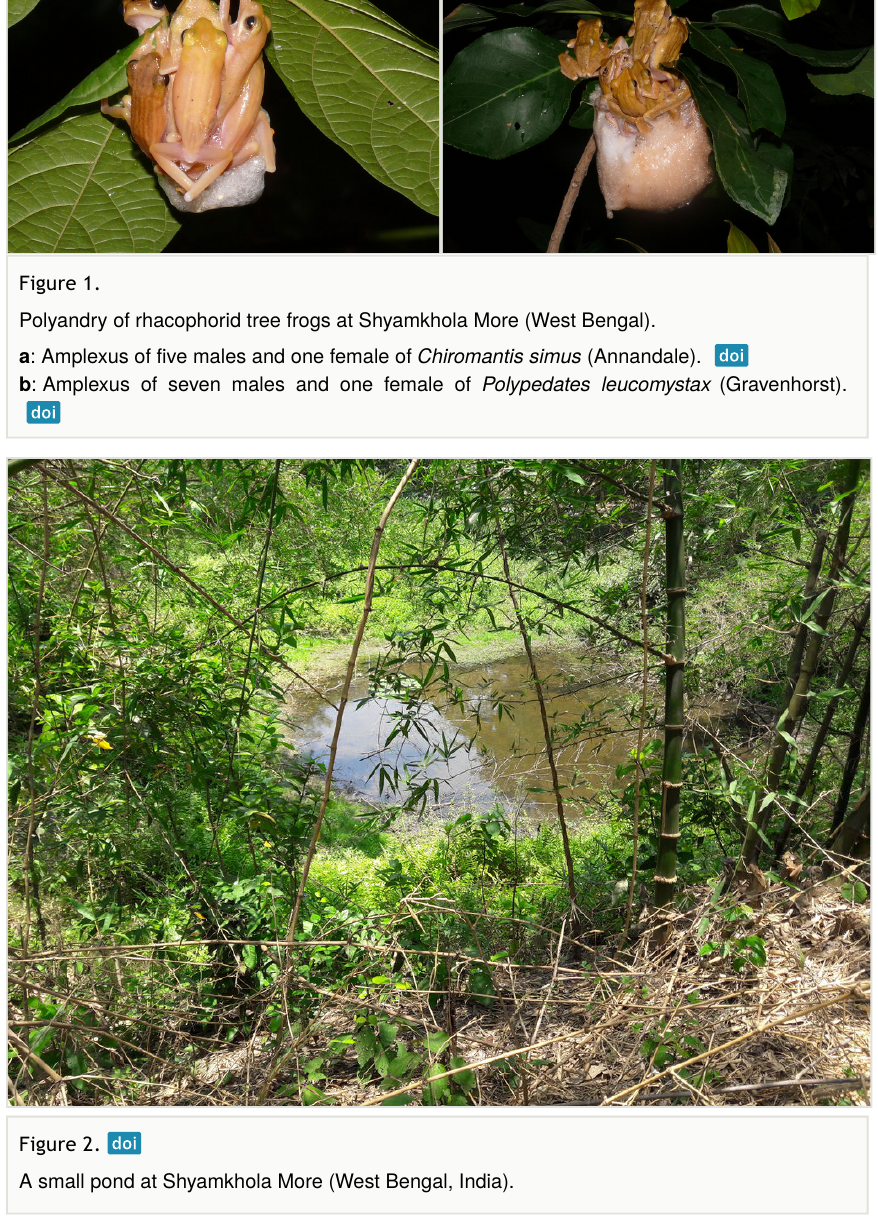
Figure 2. A small pond at Shyamkhola More (West Bengal,